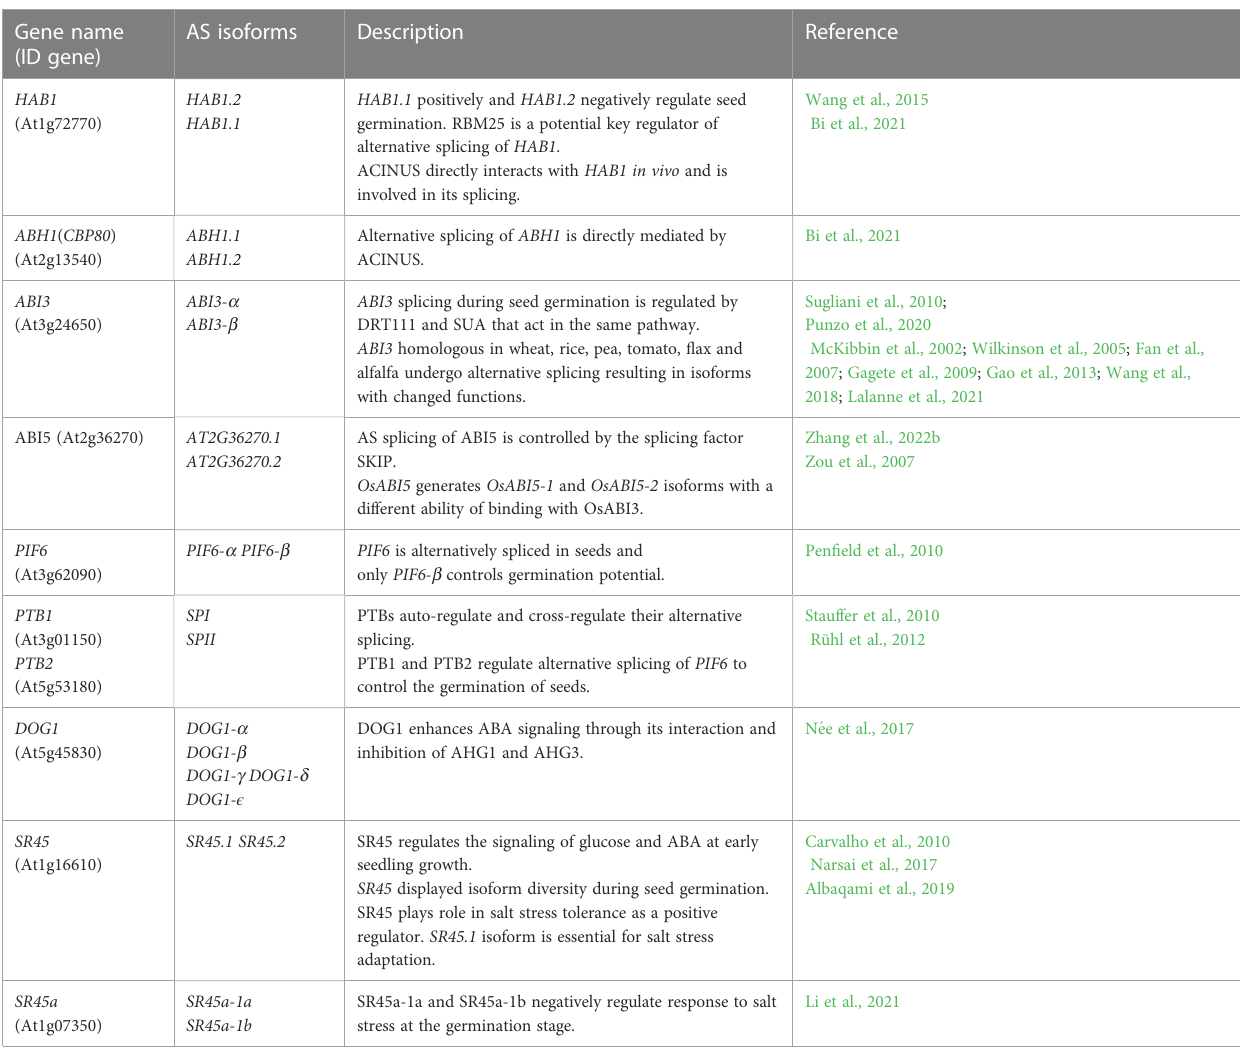
TABLE 1 List of ABA-related alternatively spliced genes that regulate seed